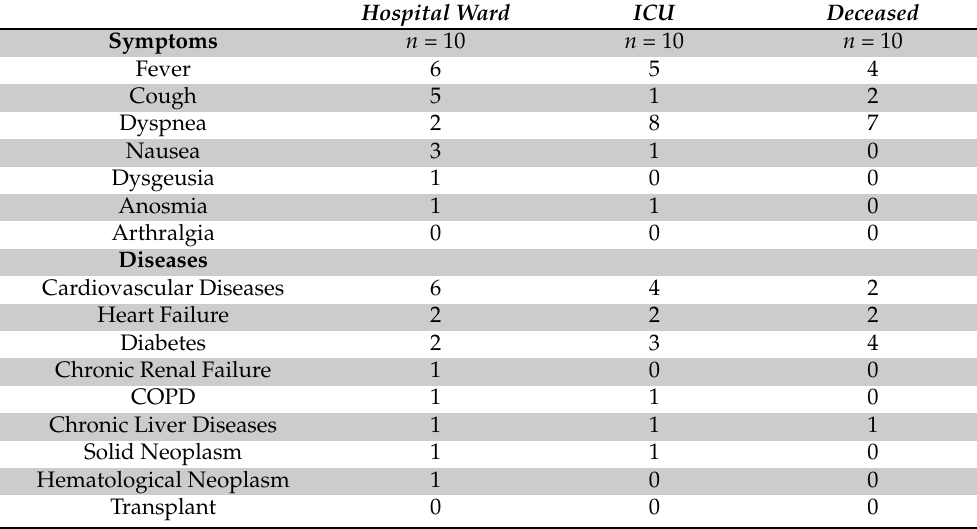
Table 1. Clinical characteristics of COVID-19 patients according to their medical